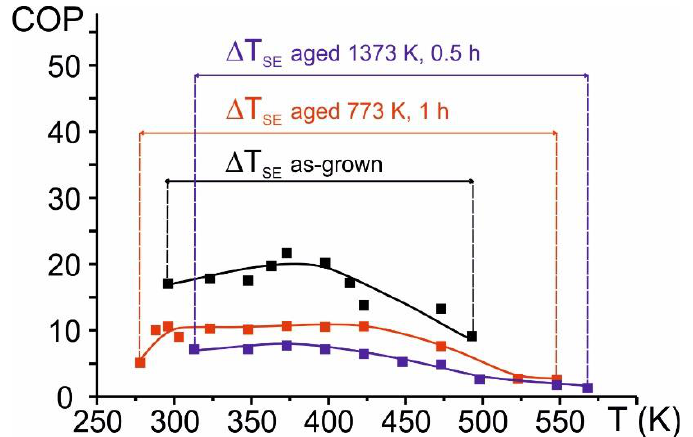
Figure 9. The temperature dependence of the COP in [001]-oriented Ni 54 Fe 19 Ga 27 single crystals.